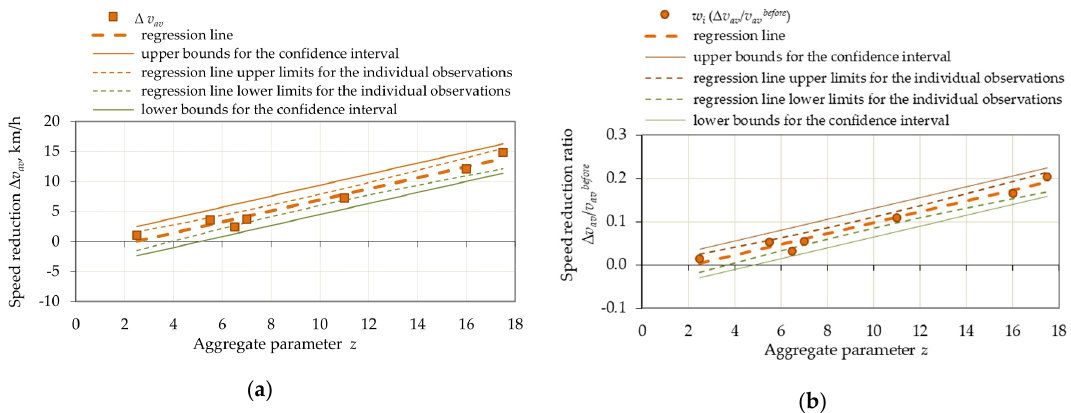
Figure 20. Linear regression function defining the relationship between: ( a ) the free-flow speed reduction ∆ v av and the aggregate parameter z , ( R = 0.98); ( b ) the free-flow speed reduction index w ( v av ) and the aggregate parameter z ( R = 0.99).